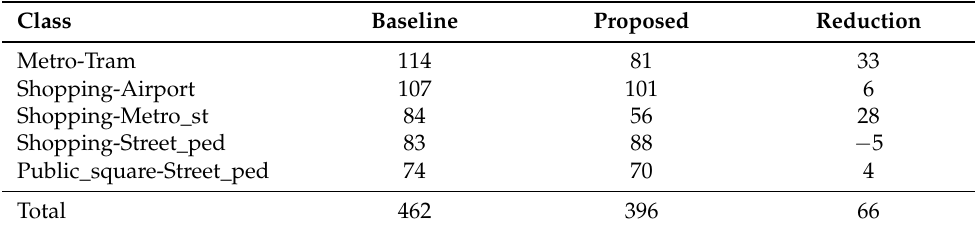
Figure 3. Confusion matrices for comparing frequently misclassified pairs of classes. The numbers in the box describe the mismatch between actual and predicted classes. The darker colors indicate more confusion. Table 4. Comparison of errors when classifying frequently misclassified pairs of acoustic scenes between the baseline and the proposed system. Reduction refers to the number of misclassified pairs.